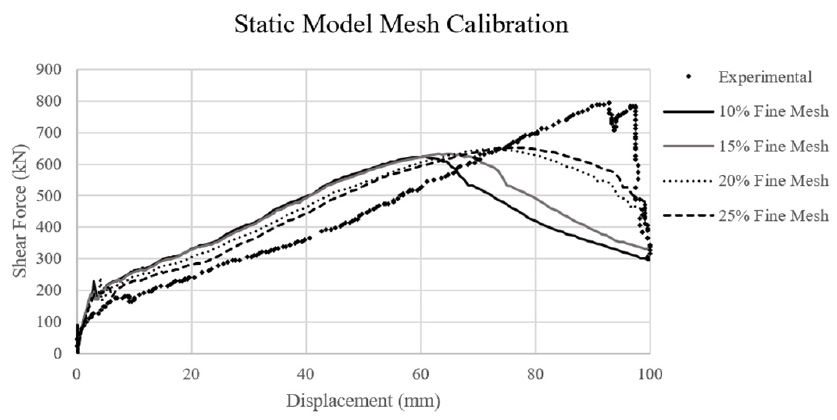
Figure 14. Force vs. displacement graph comparing fine meshes of static model.